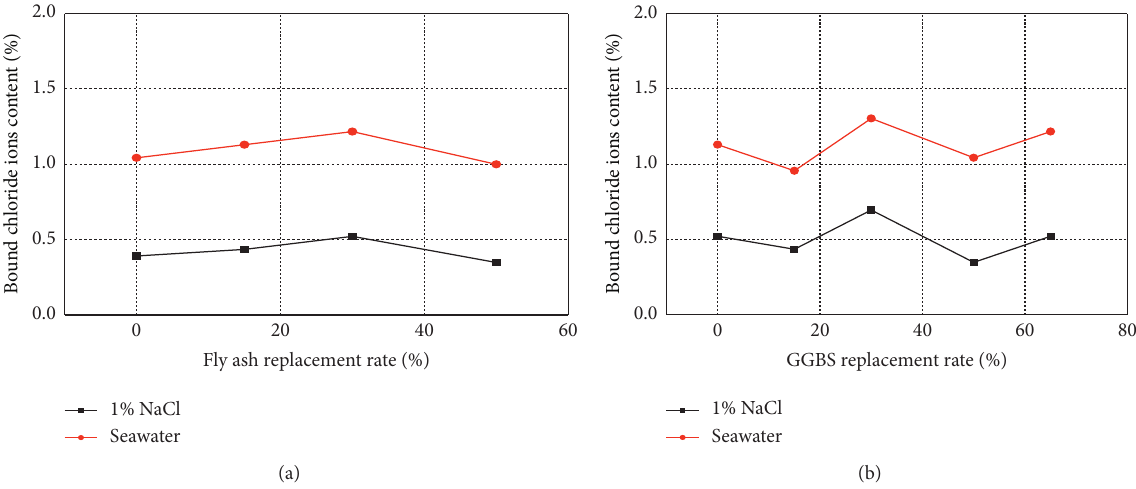
Figure 12: Bound chloride ions content of concrete powder in chloride salt solution and seawater. (a) With fly ash. (b) With